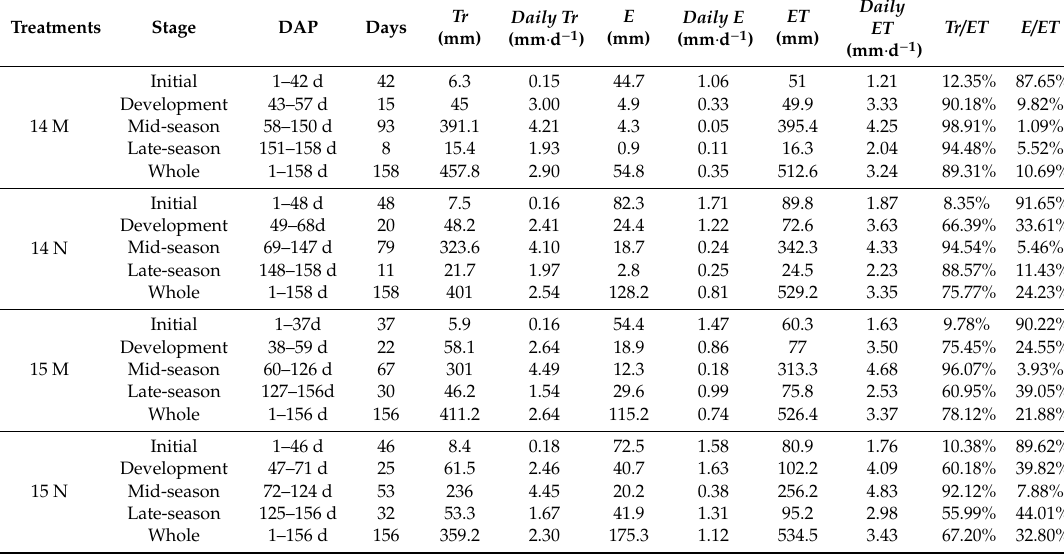
Table 4. ET , Tr , E , and the percentage of Tr and E to ET in di ff erent growth stages for treatments with and without plastic film mulch (M and N) in 2014 and